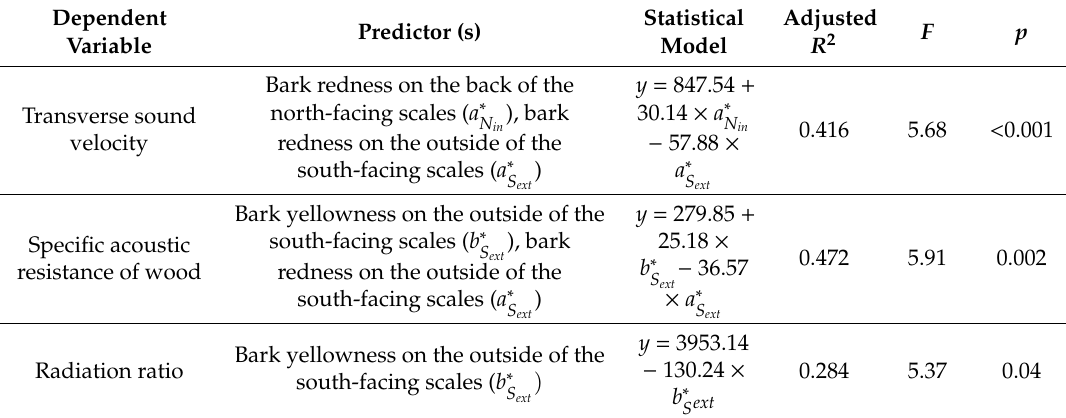
Table 7. Bark as predictor of the acoustic properties of spruce wood (only regressions with R > 0.5 are shown).